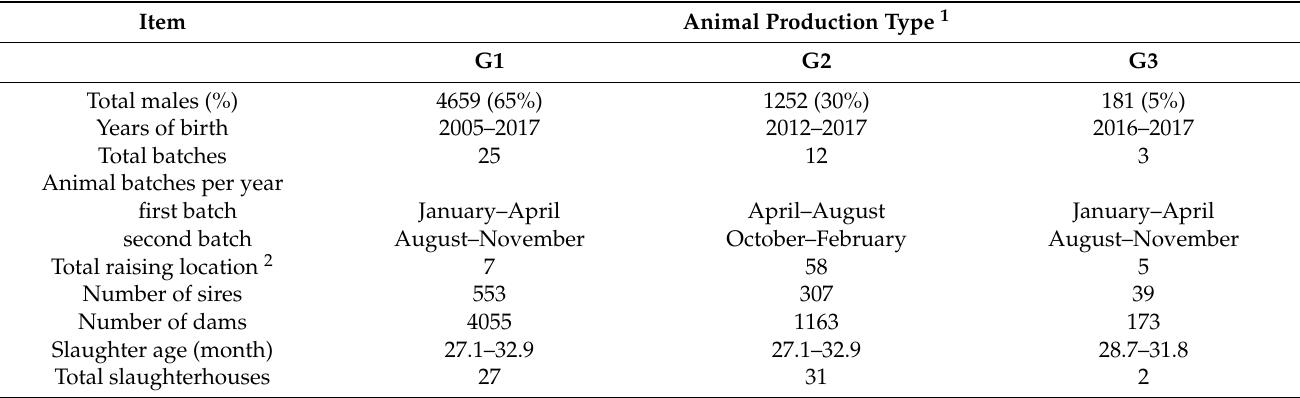
Table 1. Details of 30-month production system of Hanwoo